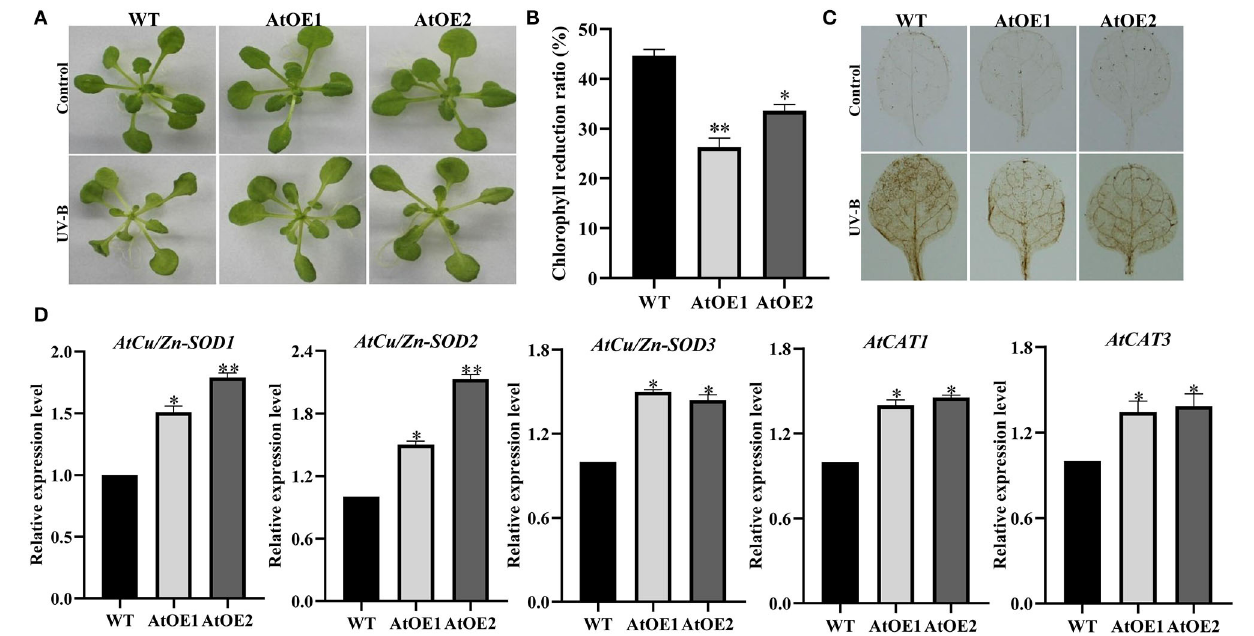
FIGURE 7 | Heterologous expression of Pn2-ODD1 enhanced the Arabidopsis resistance to UV-B radiation. (A) Three-week-old Arabidopsis were treated with 0.25 mW · cm − 2 UV-B intensity for 12h and then recovered for 3 days. (B) Chlorophyll degradation ratio of WT plants and AtOE lines. (C) Levels of hydrogen peroxide (H 2 O 2 ) measured by 3,3 ′ -diaminobenzidine (DAB) staining under UV-B radiation. (D) Gene expression patterns of antioxidant enzymes under UV-B treatment. Asterisk (*) represents a significant difference between the WT plants and AtOE lines (Student’s t -test, * P < 0.05, ** P <